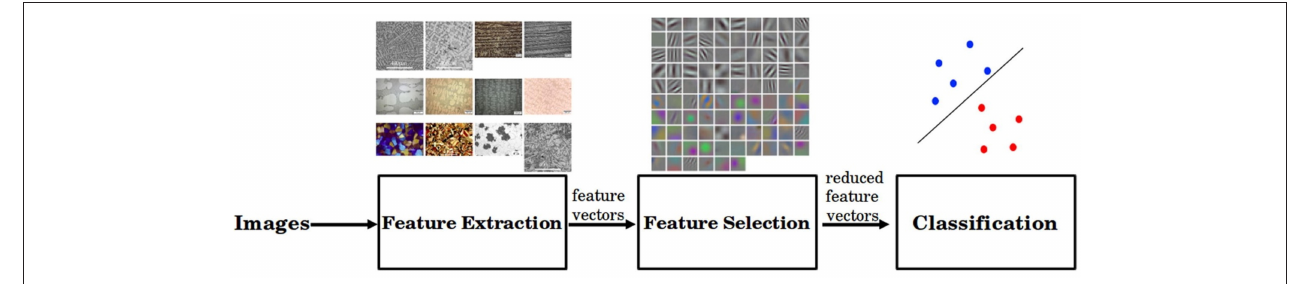
FIGURE 5 | Schematic illustration of a micrograph classification approach on different material compositions including feature extraction, feature selection and classification methods used. The two classification tasks were to first differentiate between dendritic and non-dendritic microstructures and second to recognize longitudinal and transverse dendrite orientations. Reprinted from Chowdhury et al. (2016), Copyright (2016), with permission from Elsevier.